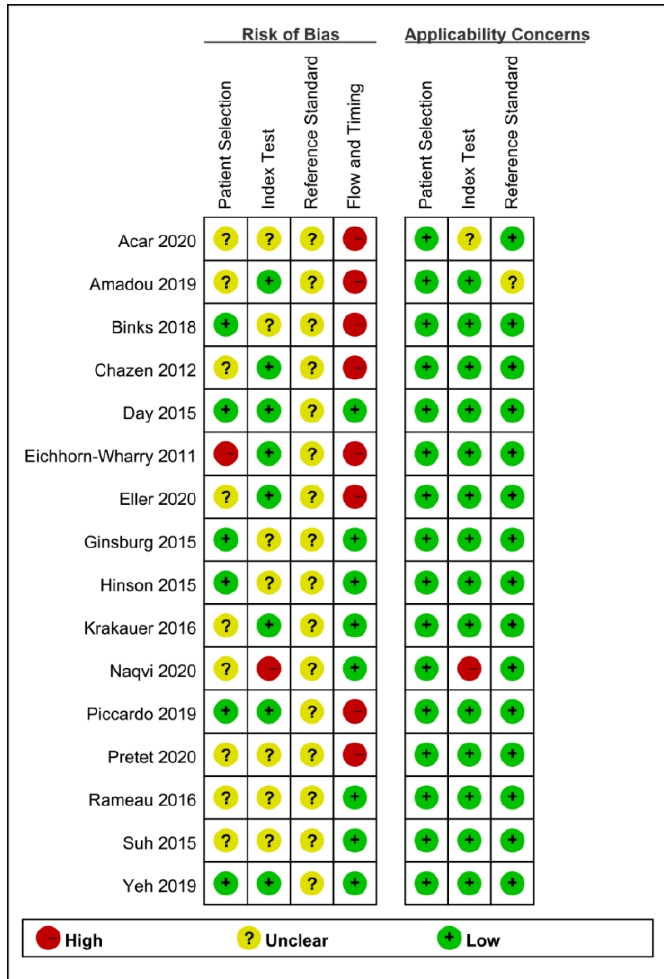
Figure 2. Methodology of included studies by Quality Assessment of Diagnostic Accuracy Studies 2 tool